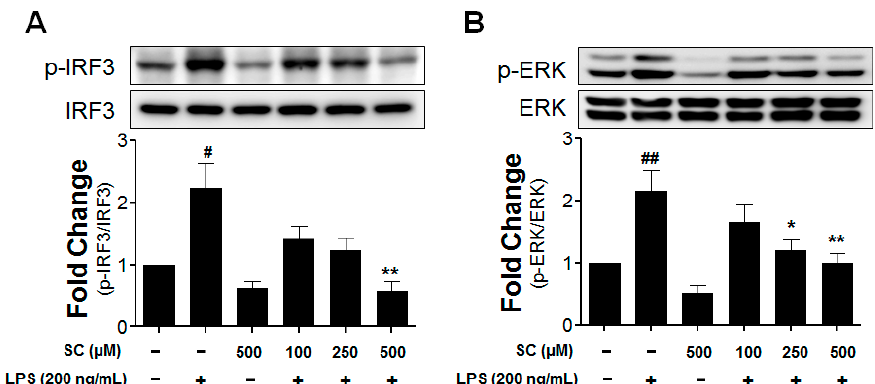
Figure 4. Effect of scoparone on mRNA expression of LPS-induced cytokines in BV-2 microglial cells. The BV-2 microglial cells were seeded at 2.5 × 10 5 cells/mL, and were incubated for 6 h with various concentrations of scoparone 1 h before the stimulation with LPS. The mRNA was first isolated, and the mRNA expressions of the tumor-necrosis factor (TNF)- α , interleukin (IL)-1 β , and interleukin (IL)-6 were then evaluated using the RT-PCR ( A ). The representative densitometry analyses of TNF- α ( B ), IL-1 β ( C ) and IL-6 ( D ) compared with GAPDH mRNA. The data are the mean ± standard error ( n = 3) of three independent experiments. # p < 0.05, ### p < 0.005, compared with the control group; * p < 0.05, ** p < 0.01, and *** p < 0.005 compared with the LPS-treated group.